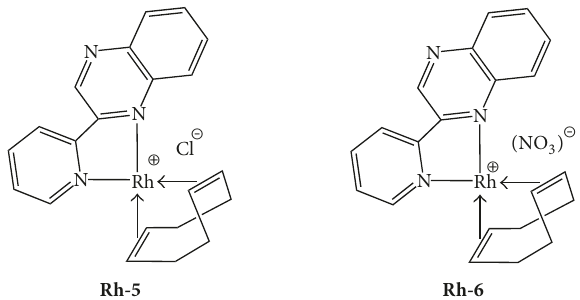
Figure 6: Molecular structure of Rh(I)